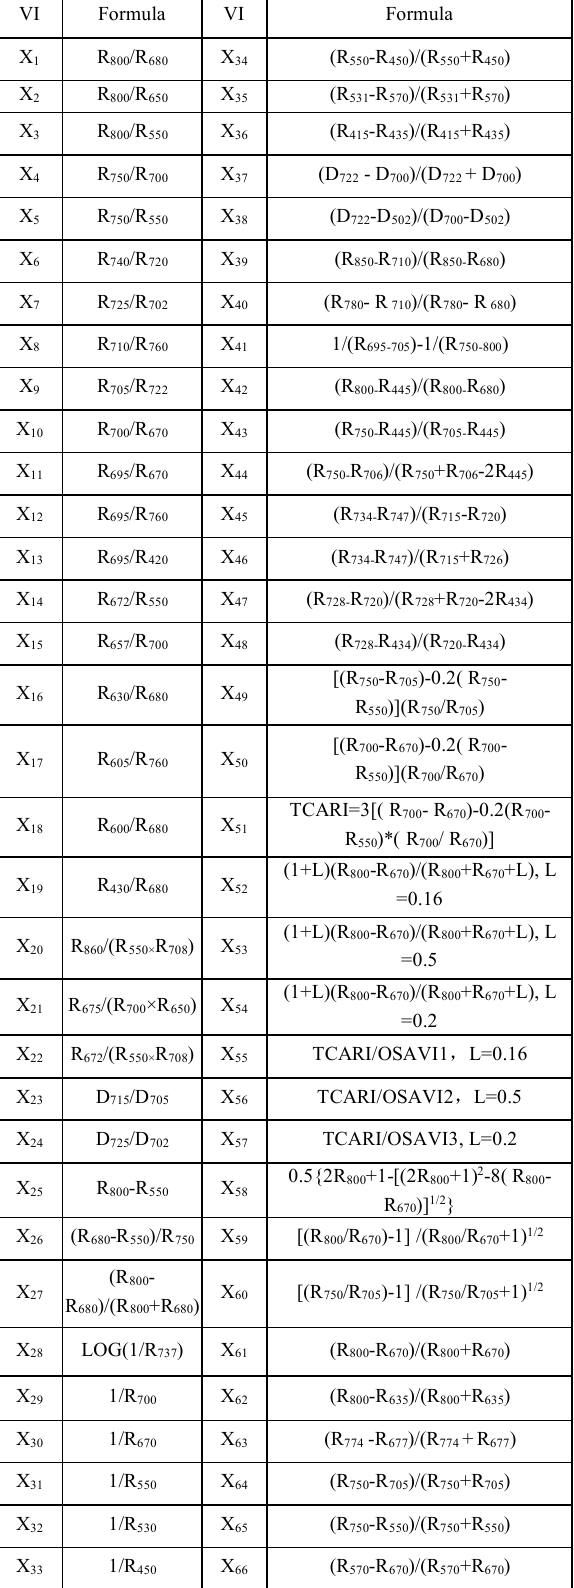
Table 2. Veagetation Indies used to estimate chlorophyll content